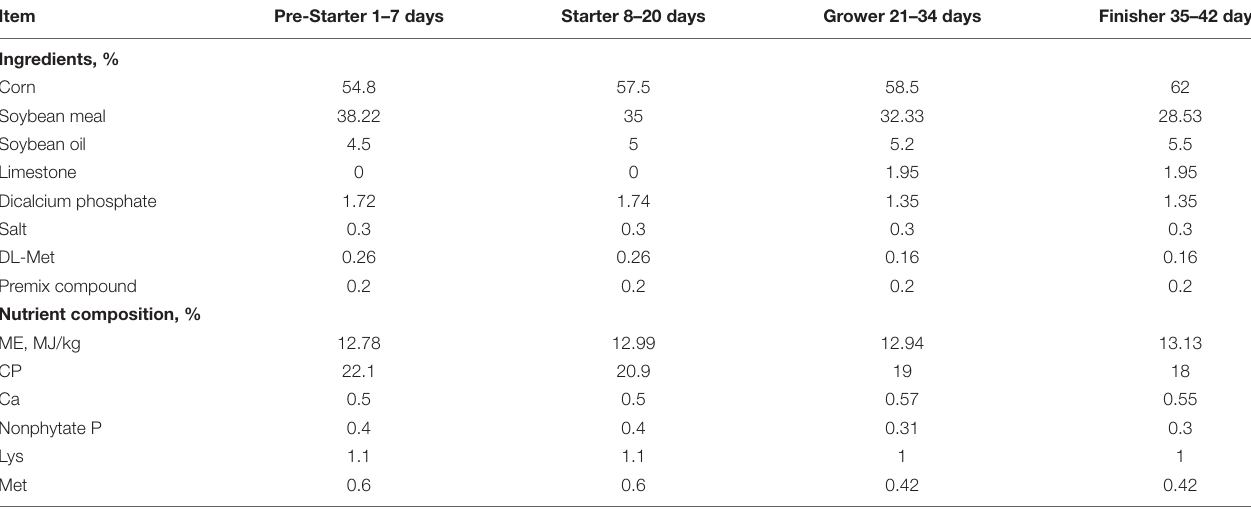
TABLE 1 | Ingredient composition of diets fed to Line B broilers from 1 to 42 days of age.